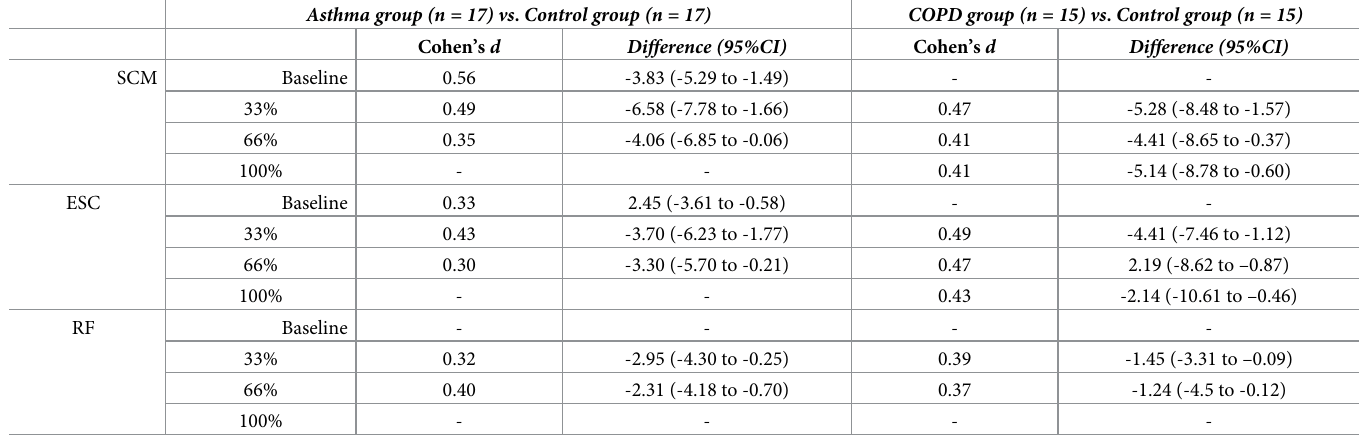
Fig 2. sEMG amplitude of SCM (A and D), ESC (B and E), and RF (C and F) muscles at baseline and during ISWT moments, in Asthma-group (close circles) on upper panel, COPD-group (close triangles) on the lower panel, and their respective control group (open square). § Mann-Whitney Test: difference between groups. � Friedman Test: compared to baseline. https://doi.org/10.1371/journal.pone.0266365.g002 Rectus femoris (RF). %RMS of RF was greater in asthma group at 33% (p = 0.02) and 66% (p = 0.004) of total ISWT time. In asthma group, %RMS of RF increased immediately after initiating ISWT (33% ISWT moment) (p < 0.0001, Kendall’s W = 0.82). In asthma con- trol group, %RMS of RF increased from 66% of total ISWT time (p < 0.0001, Kendall’s W = 0.87) (Fig 2C). COPD group was significantly different from COPD control group at 33% (p = 0.032) and 66% (p = 0.039) of total ISWT time. In both groups, %RMS of RF also increased at 33% of ISWT (p < 0.0001, Kendall’s W = 0.86 for the COPD group and p < 0.0001, Kendall’s W = 0.82 for the COPD control group) (Fig 2F). Effect sizes and differ- ences [95%CI] between groups for all muscles evaluated are shown in Table 4. Power spectrum density of sEMG signal during ISWT. MF slopes decreased linearly in all muscles during ISWT. Moreover, intergroup differences were observed for ESC (p = 0.016) and RF (p < 0.0001) muscles with higher slopes in asthma group (Fig 3). MF decreased linearly in SCM and RF of COPD group. Slopes were different for SCM (p < 0.0001) in intergroup Table 4. Effect size and difference (95% CI) values of EMGs amplitude between